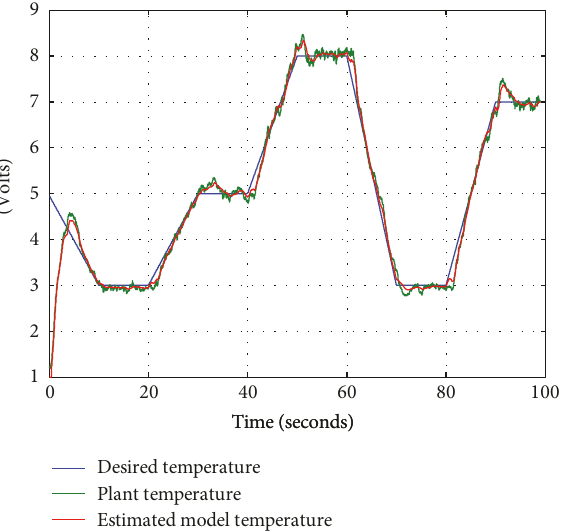
Figure 17: Temperature control of heating process.